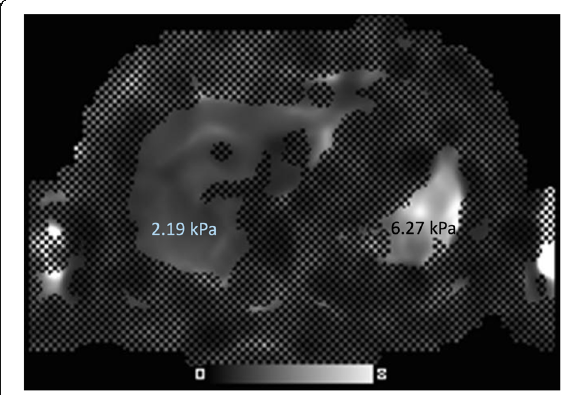
Fig. 4 Spleen fibrosis in pediatric Gaucher disease. Axial MR elastography of a 13-year-old patient with newly diagnosed, untreated type 1 Gaucher disease demonstrates elevated spleen stiffness values (6.27 kPa, abnormal defined greater than 3.6 kPa), but no significant hepatic fibrosis identified (2.19 kPa, abnormal defined greater than 2.9